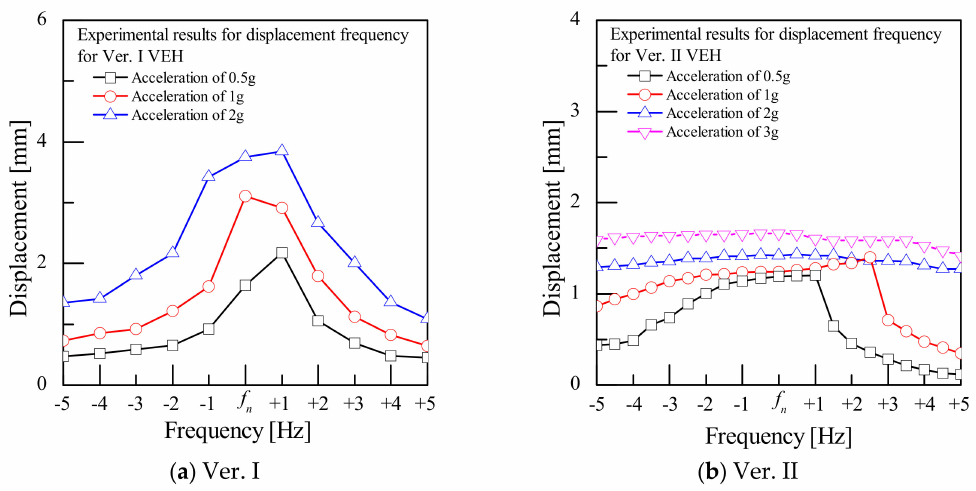
Figure 5. Measured displacement–frequency curve using sine dwell